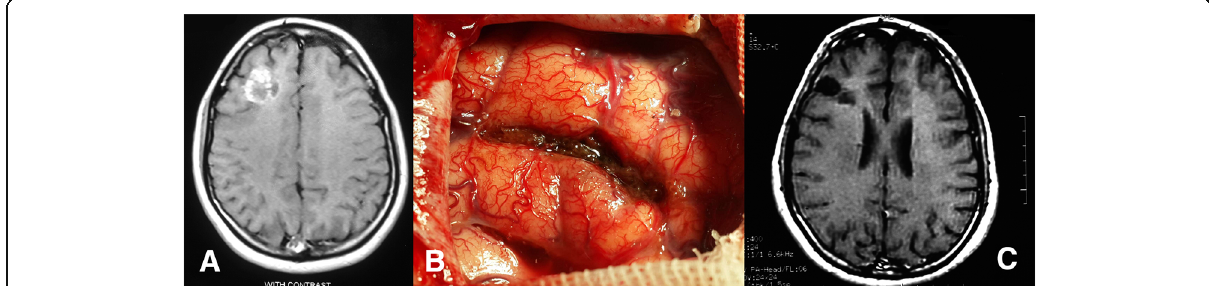
Fig. 3 a Axial T1 MRI, right frontal Cavernoma. b The operated site showing the sulcal dissection after lesion removal and the sulcal cavity is filled with a hemostatic agent. c Axial T1 MRI eight-month